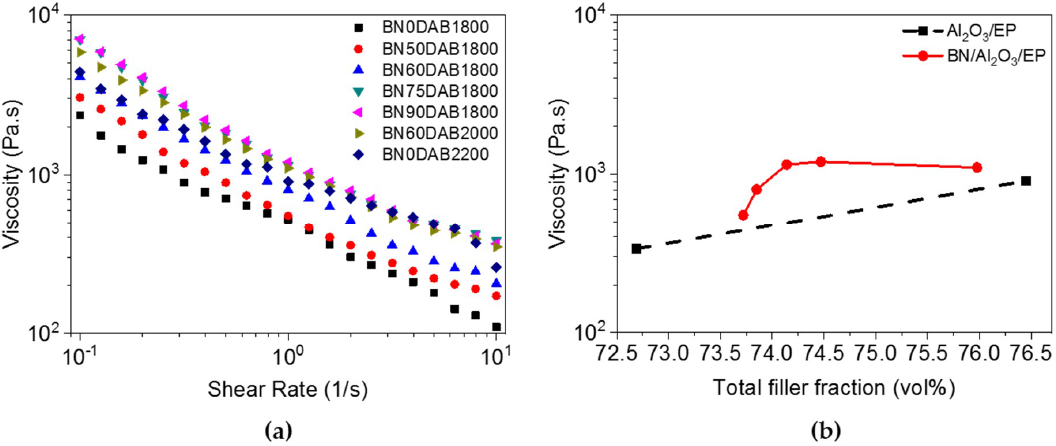
Figure 2. Steady shear viscosities ( a ) and viscosity at a shear rate of 1 s − 1 vs. total filler fraction of Al 2 O 3 /epoxy resin (EP) and boron nitride (BN)/Al 2 O 3 /EP ( b ).